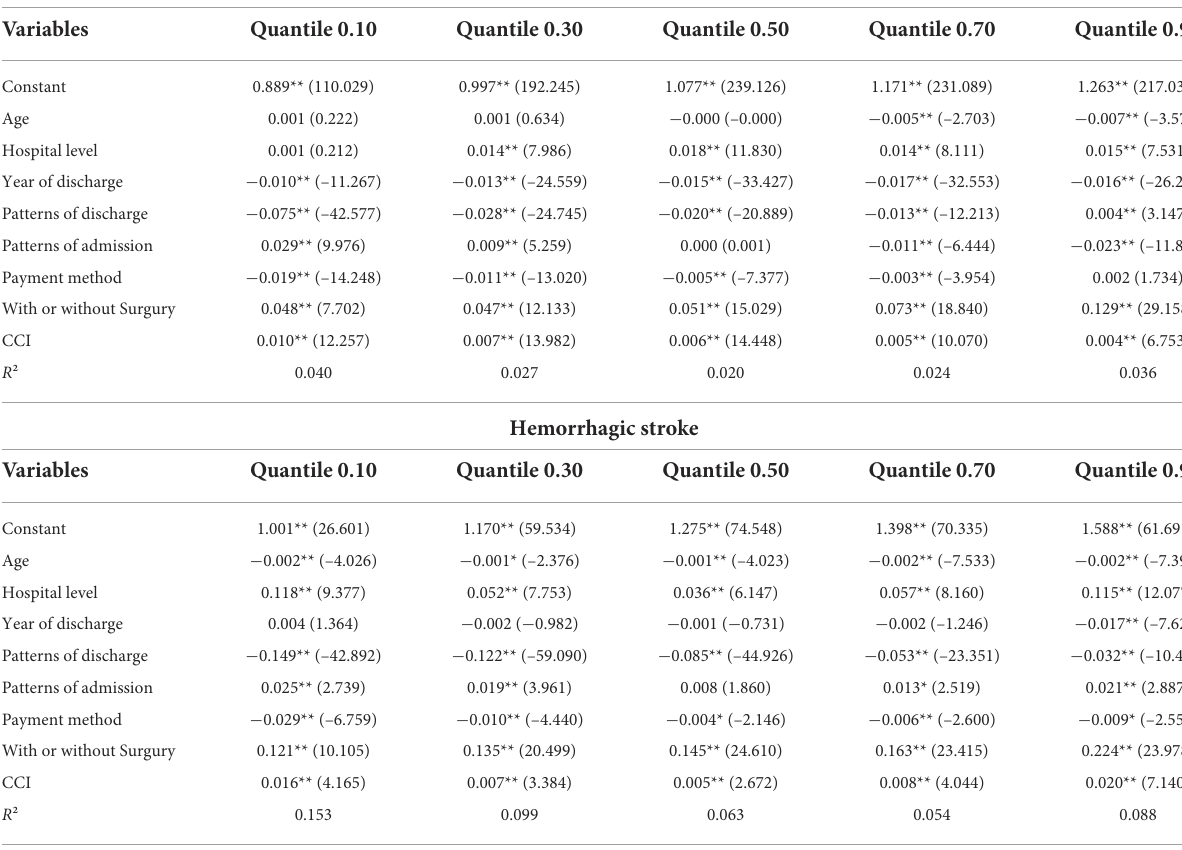
TABLE 3 Association between the factors and the length of hospitalization stay with the in the quantile regression model. Ischemic stroke